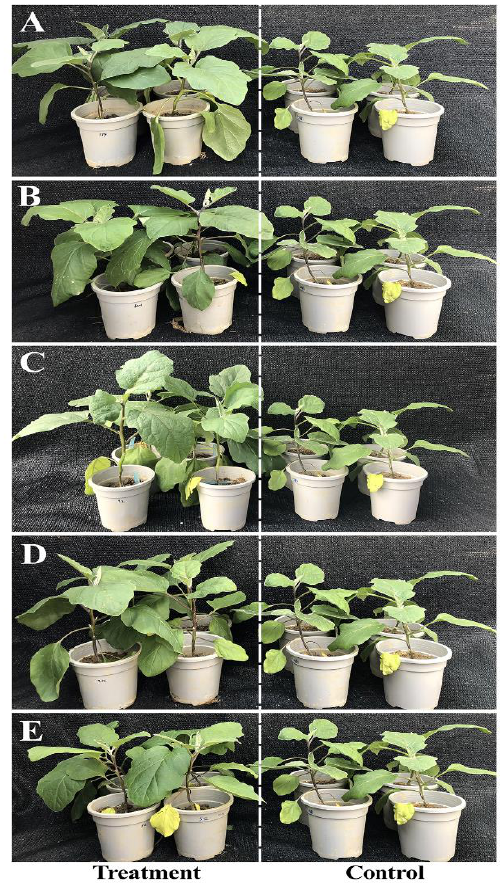
Figure 6. Effect of five bacterial strains on eggplant growth in new reclaimed soil 30 d after inoculation. After sowing the germinated seeds into the 32-cell seed growing trays containing the cocopeat substrate and growing for about 6 weeks, eggplant seedlings at the four-leaf stage were transplanted into pots containing unsterilized soil from the new reclamation land with pH 5.0, while 10 mL of cell suspension (about 10 8 cfu/mL) of each test strain was poured into the soil around the plants. The plants inoculated with sterile water were used as the control. Each treatment had three replicates with 10 plants in each replicate. The photos of plants were taken by randomly placing 4 plants from each treatment. The uninoculated control plants from different treatments were the same. ( A ). Inoculation with strain ZJ174. ( B ). Inoculation with strain ZJ62. ( C ). Inoculation with strain ZJ9. ( D ). Inoculation with strain ZJ3-12. ( E ). Inoculation with strain ZJ5. Table 3. Effect of five PGPB strains on growth promotion of eggplant plants at 30 d after bacterial inoculation. Strains SH (cm) GPE% RL (cm)